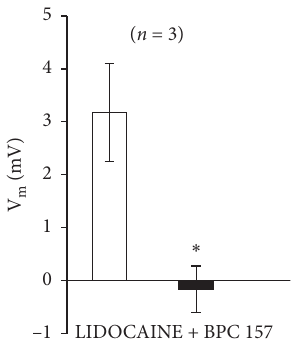
Figure 12: Lidocaine (1mM) depolarized HEK293 cells which was inhibited in the presence of 1 μ M BPC 157. Results are presented as average ± SEM. ∗ P < 0 . 05 statistically significant difference com- pared to effects of